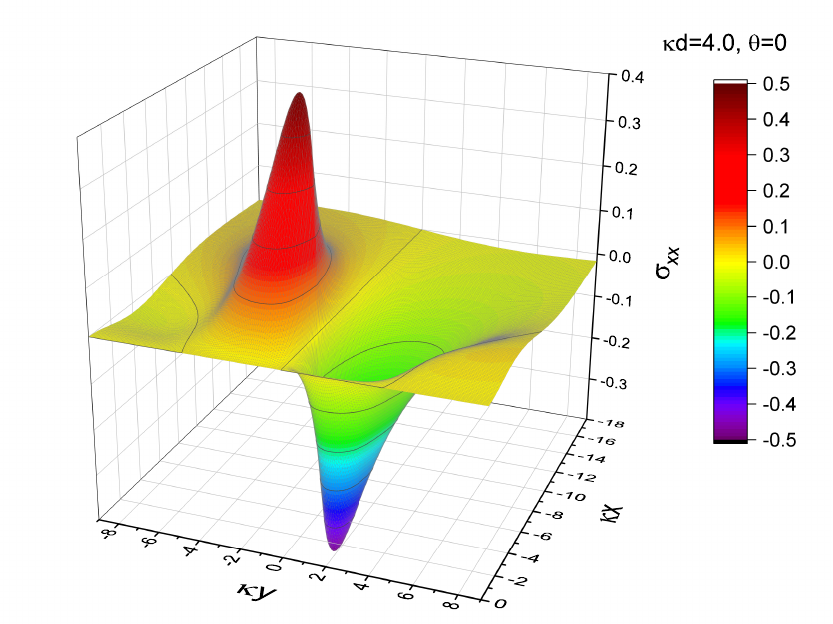
Figure 3. Three-dimensional plot of σ xx for the case of κ d = 4.0 and θ = 0, which is shown in Figure 2b. The unit of stress is µκ b /2 ( 1 − ν ∗ ) . The smoothness and continuity in the stress field with no singularity near the dislocation-core can be visually confirmed.